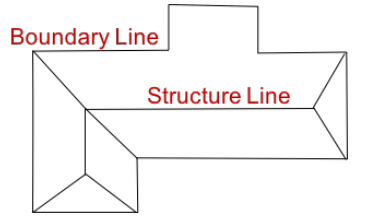
Figure 1. conceptual building boundary lines.